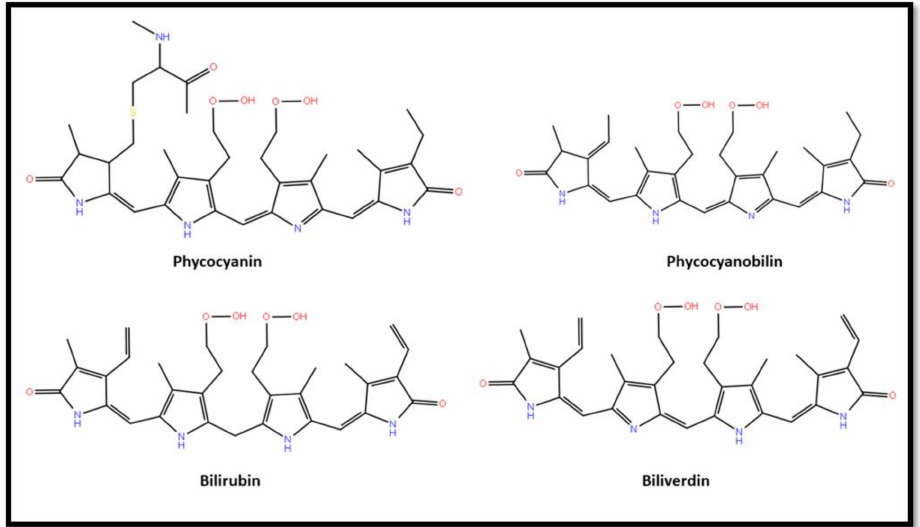
Figure 2. The 2D chemical structures of phycocyanin, phycocyanobilin, bilirubin, and